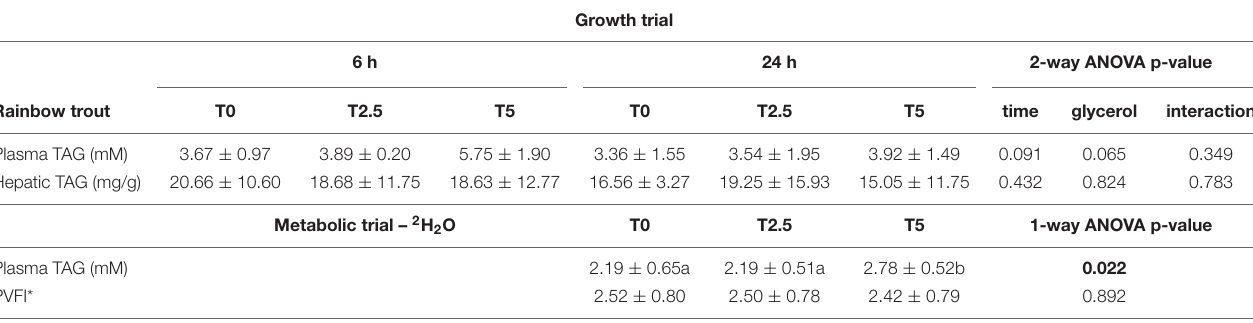
TABLE 1 | Plasma and liver parameters for rainbow trout ( Oncorhynchus mykiss ) fed with different levels of glycerol (0, 2.5, and 5%) for 8 weeks sampled at the end of the growth trial at 6 h and 24 h after last meal and the metabolic trial (6-day residence in 2 H-enriched water) 24 h after last meal. Growth trial